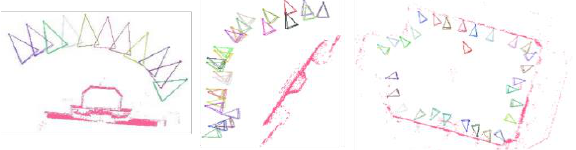
Figure 7. Visualization of benchmarks’ SfM results by “HM” (after bundle adjustment). Colourful triangles denote exterior pose parameters; red dots are estimated 3D object